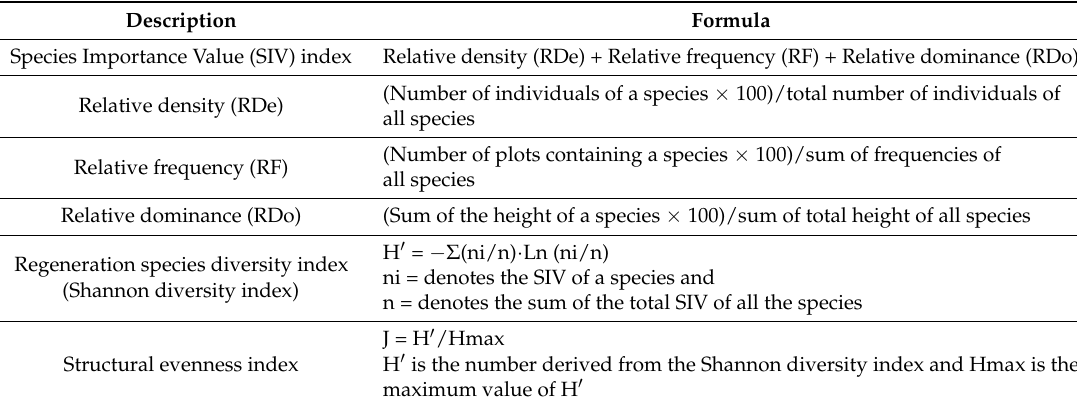
Table 3. Detailed formulas and descriptions of the Species Importance Value (SIV) index, Regeneration species diversity index and structural evenness